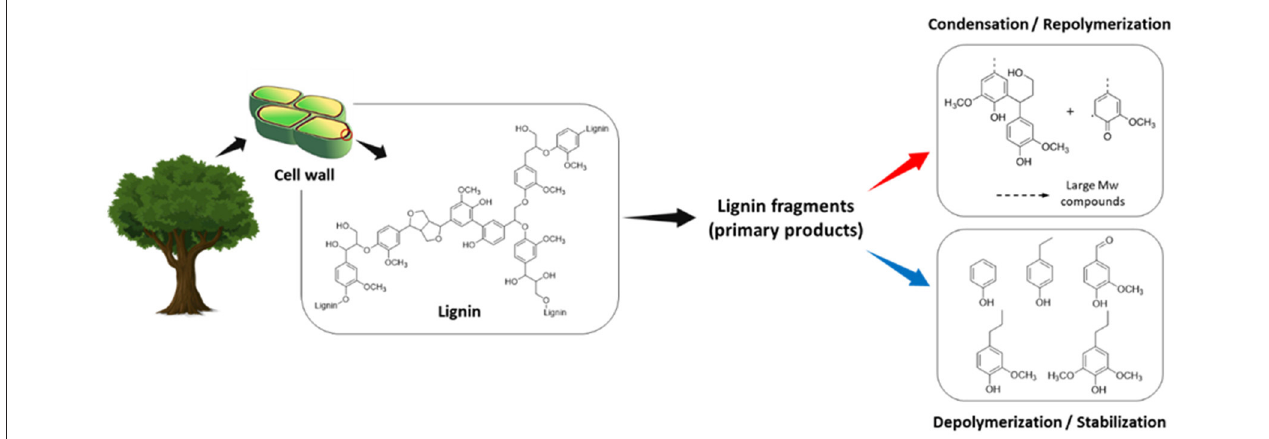
FIGURE 1 | Lignin depolymerization and repolymerization